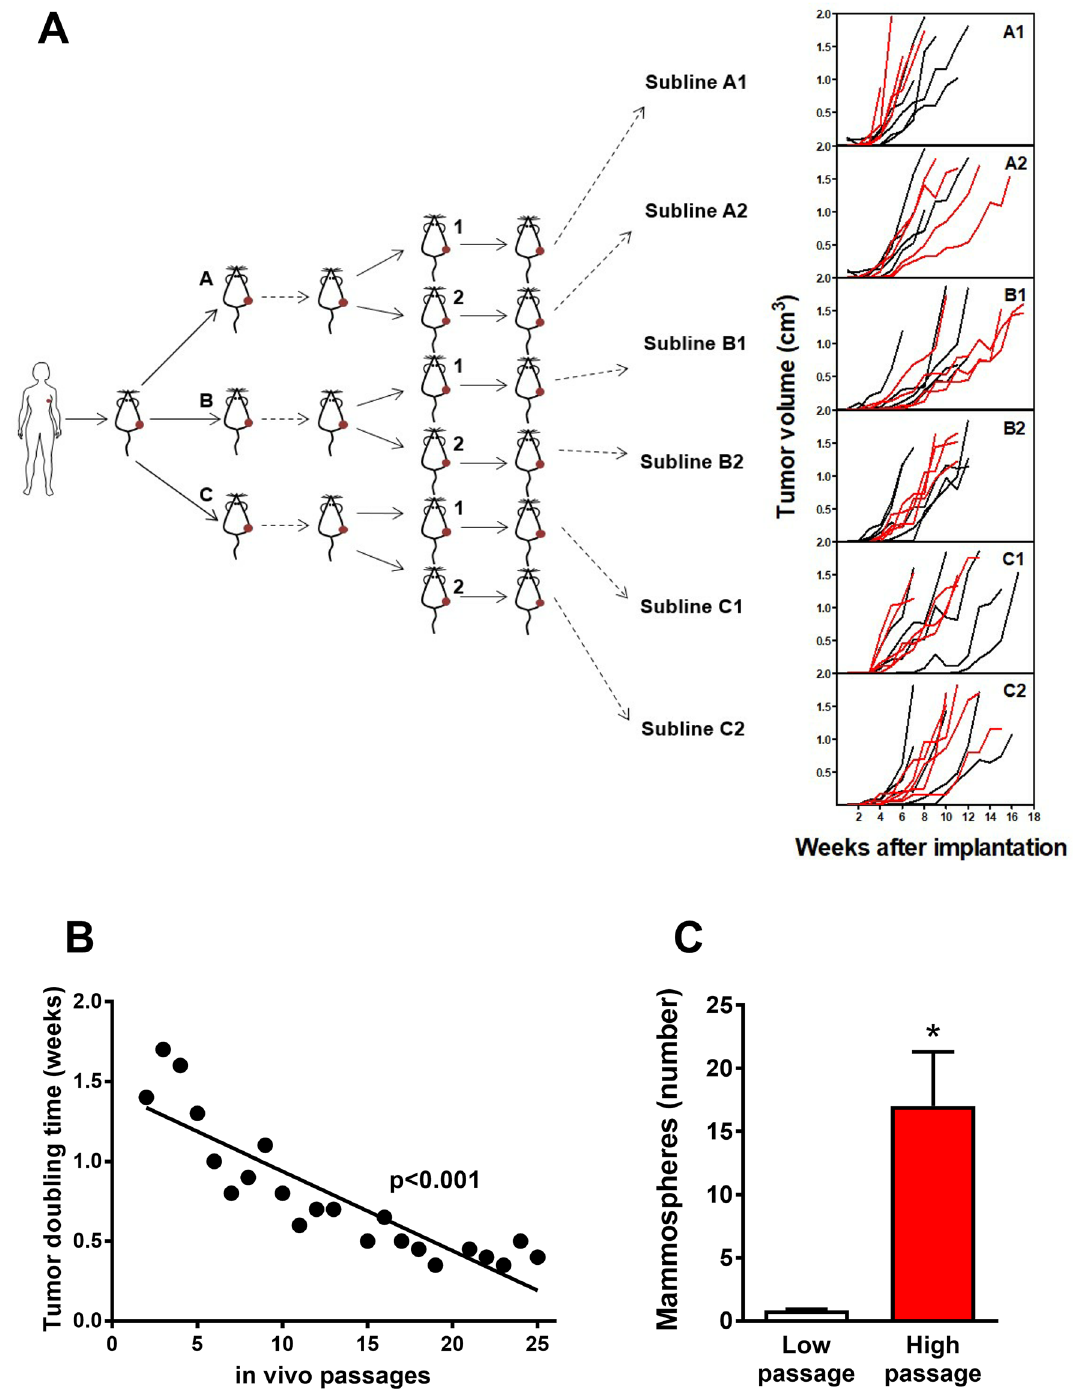
Figure 3. Random progression in sublines of PDX-BRB4. ( A ) Origin of independent sublines of PDX-BRB4 (see “Methods”) and growth kinetics during in vivo passages. Right panels show individual tumor growth curves of sublines at low-passage (passage 4–8, black lines) and high-passage (14–18, red lines). ( B ) Tumor doubling time of subline PDX-BRB4-A1 during long-term in vivo passages (up to approximately 4 years), calculated in the exponential growth phase. Significance of linear regression is shown in the panel. ( C ) Mammospheres formed in vitro by PDX-BRB4-A1 at low (8) and high (23–26) passage. Mean and SEM of 3–4 independent determinations (6 replicates each) are shown. *p <